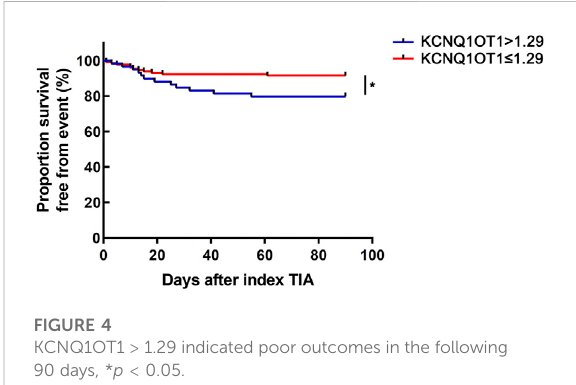
FIGURE 4 KCNQ1OT1 > 1.29 indicated poor outcomes in the following 90 days, * p <